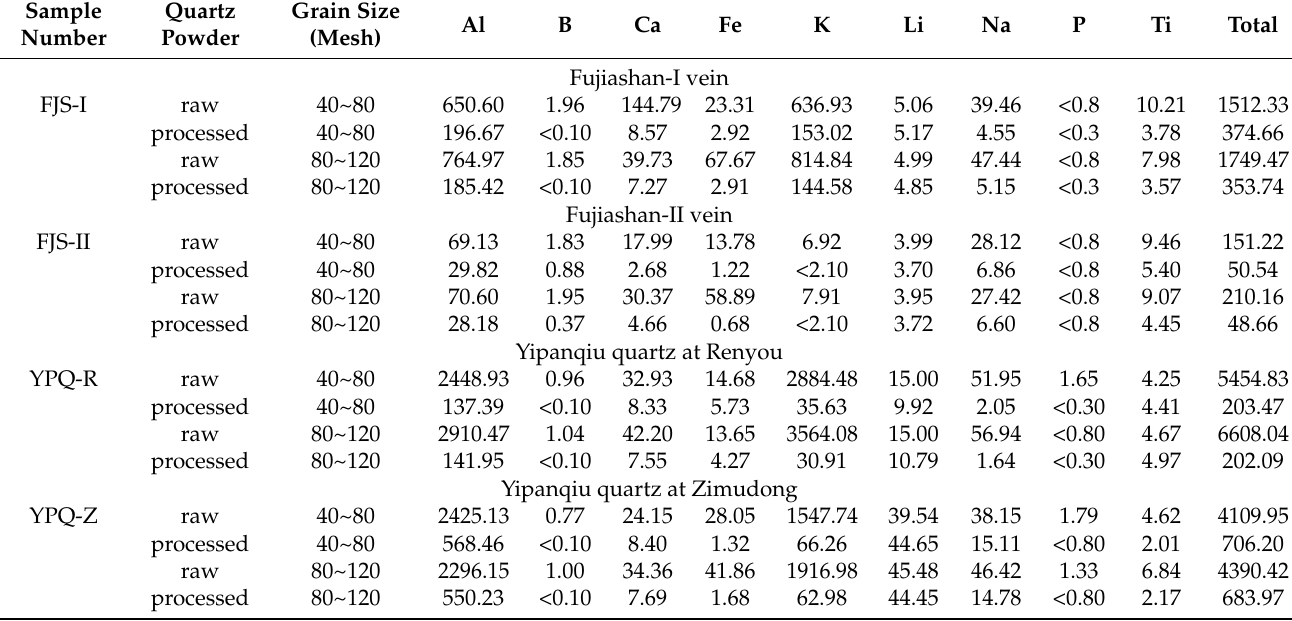
Table 1. Trace element concentrations in µ g g − 1 of raw and processed quartz samples from the Fujiashan and Yipanqiu quartz veins in southeastern Hubei Province (China) determined by bulk solution ICP-OES